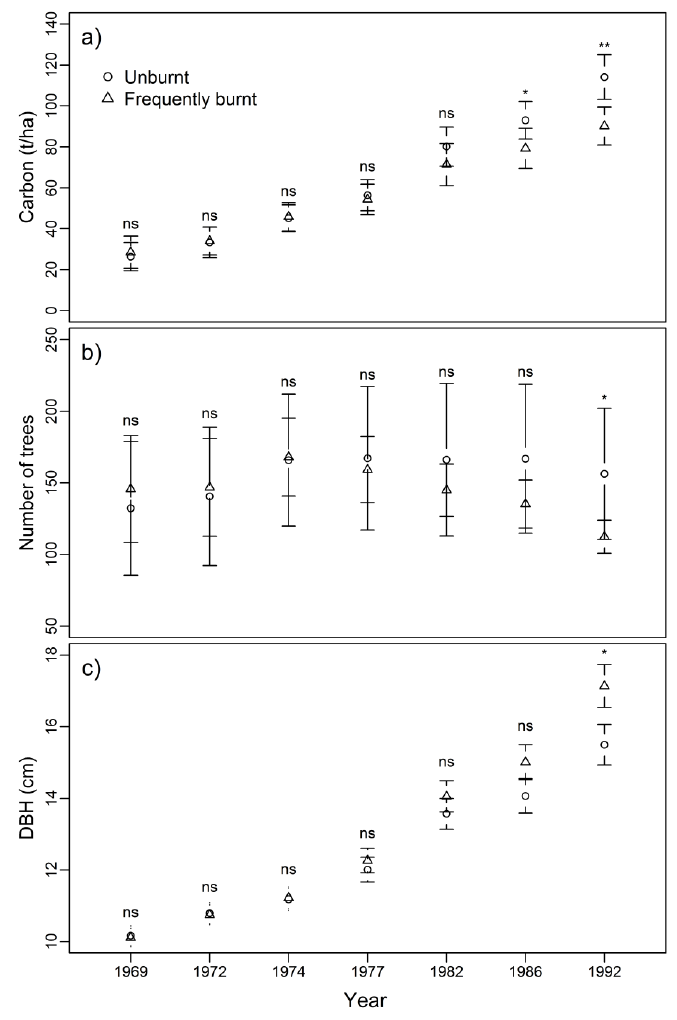
Figure 1. Mean and 95% confidence interval for ( a ) estimated carbon biomass (tha −1 ), ( b ) number of trees and ( c ) tree diameter for overstorey species on frequently burnt and unburnt plots across all survey periods. Symbols above error bars show the results of one way analysis of variance ( a , b ) or linear mixed models ( c ) comparing the effects of burning within each treatment year (ns: p > 0.05; * : 0.05 > p > 0.01; ** : 0.01 > p > 0.001). Untransformed data is